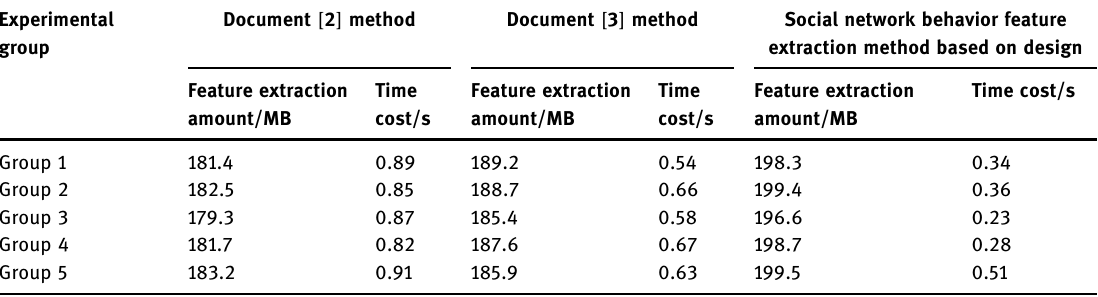
Table 4: Experimental comparison results